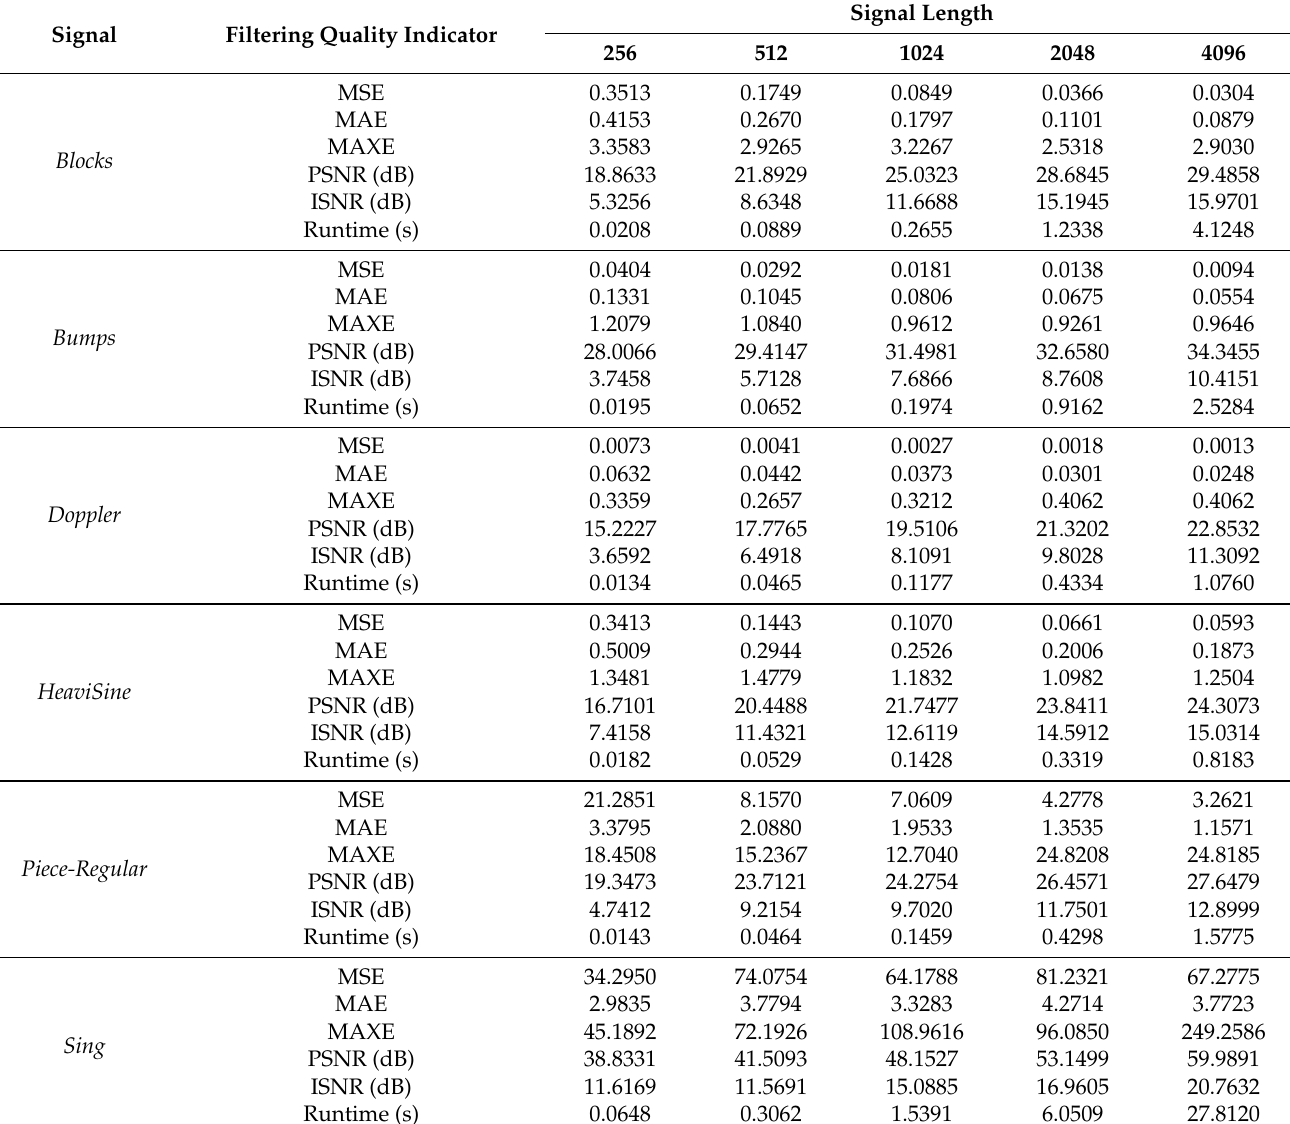
Table 43. Filtering results obtained by applying the RBF-RICI algorithm to signals of different